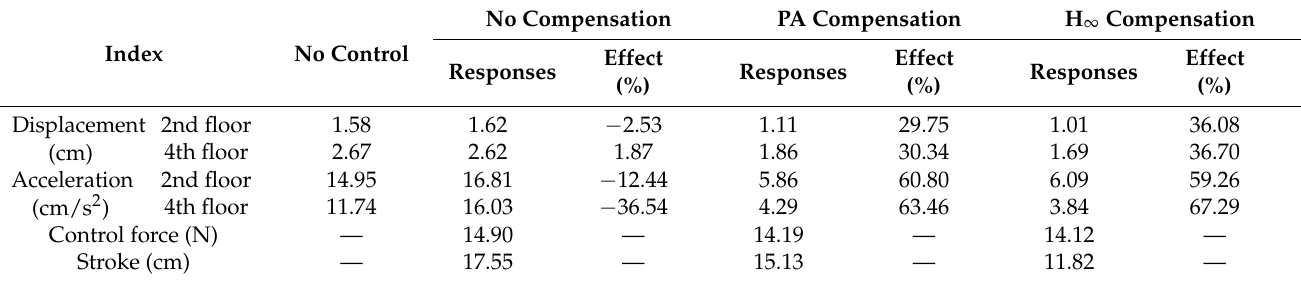
Table 4. The control effects under the measured results (mean square